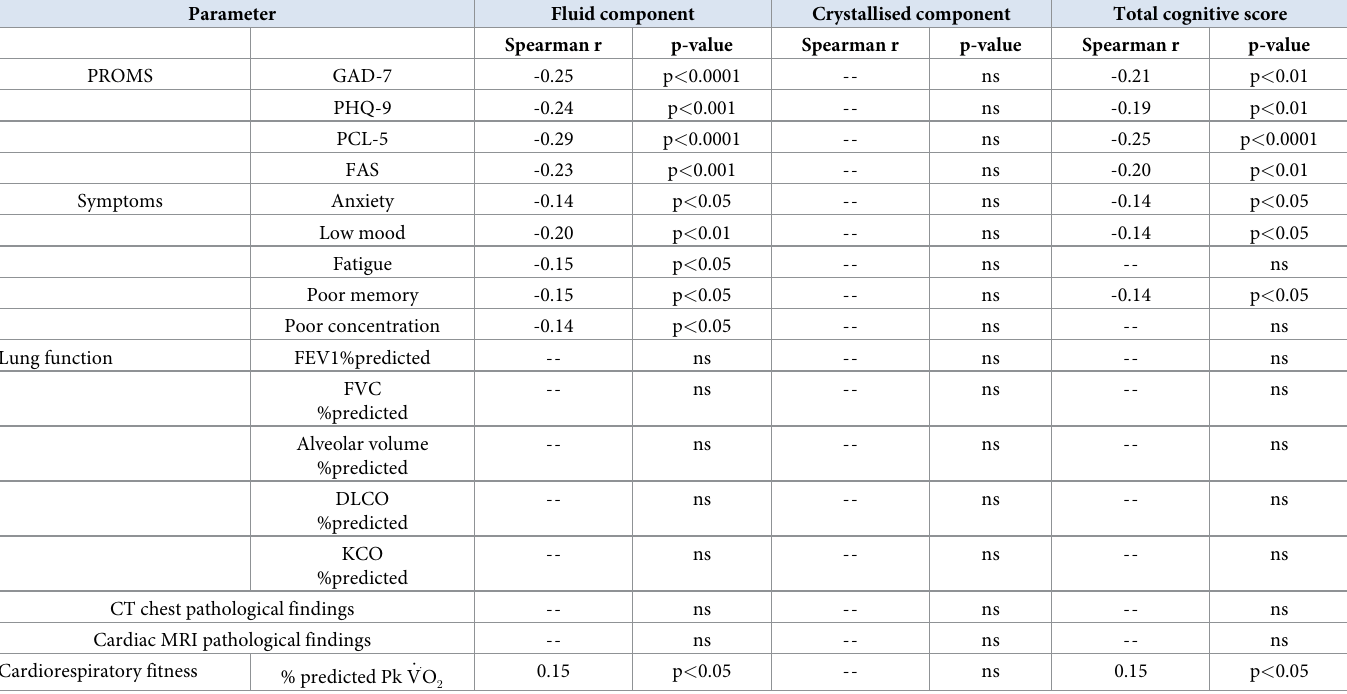
Table 5. Cognitive score: Association with PROMS, symptoms, medical findings and functional